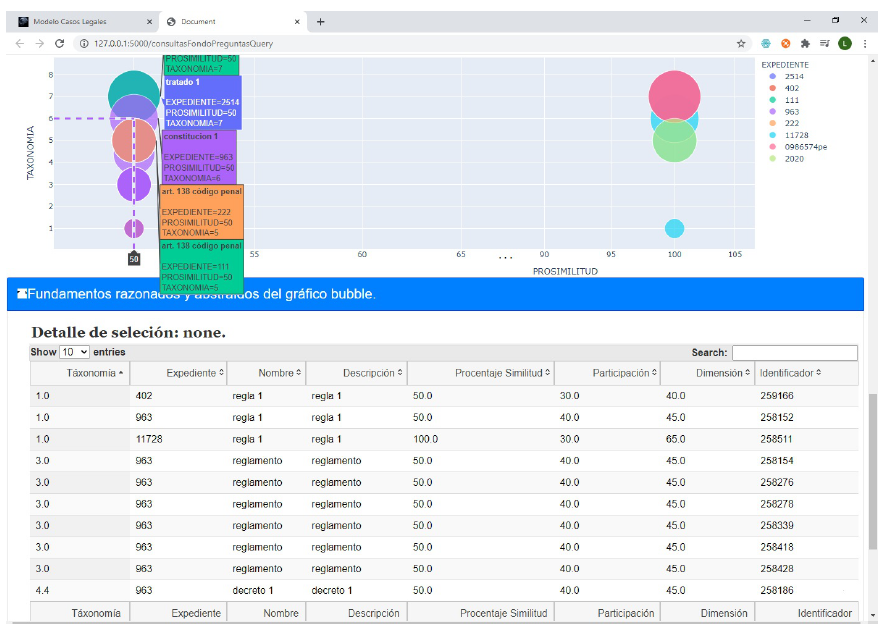
Figure 8. EGI explains to the user using circles, size, and colors, the set of laws and regulations in line with the factual picture of the case under analysis. The machine expresses by a graphical distribution of circles those norms and laws that best describe the legal scenario under study. The recommended norms and laws to take are higher and farther to the right in the chart. However, a judge can explore, analyze, and select those that best fit the factual